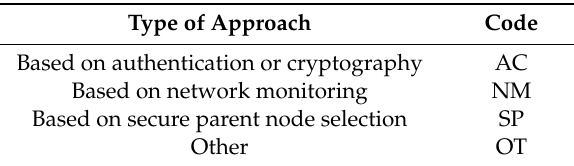
Table 6. Approach coding: presents the mechanisms or strategies used by the authors to mitigate the